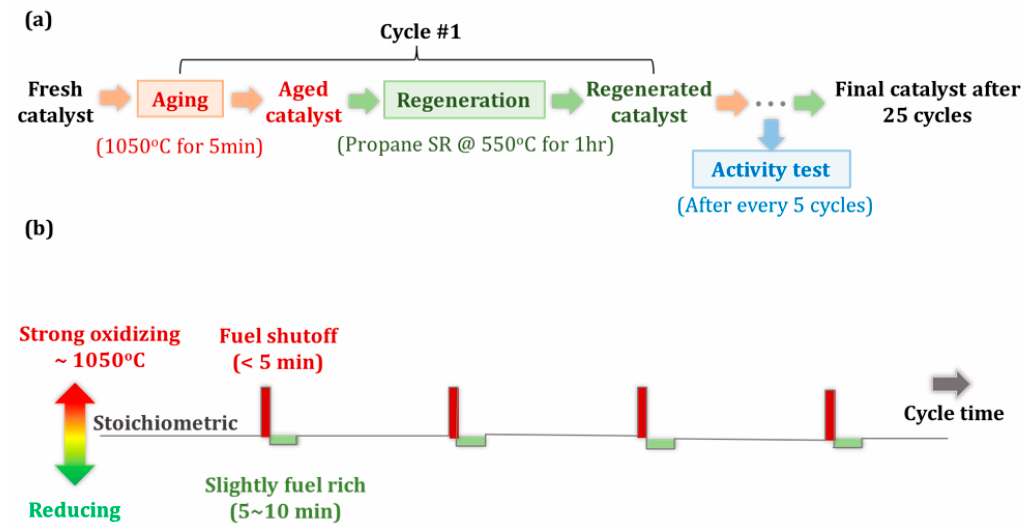
Figure 17. Schematic process flow diagrams of ( a ) simulated fuel shutoff aging-fuel rich regeneration cycle and activity test; and ( b ) on-board gasoline engine fuel shutoff-fuel rich operation